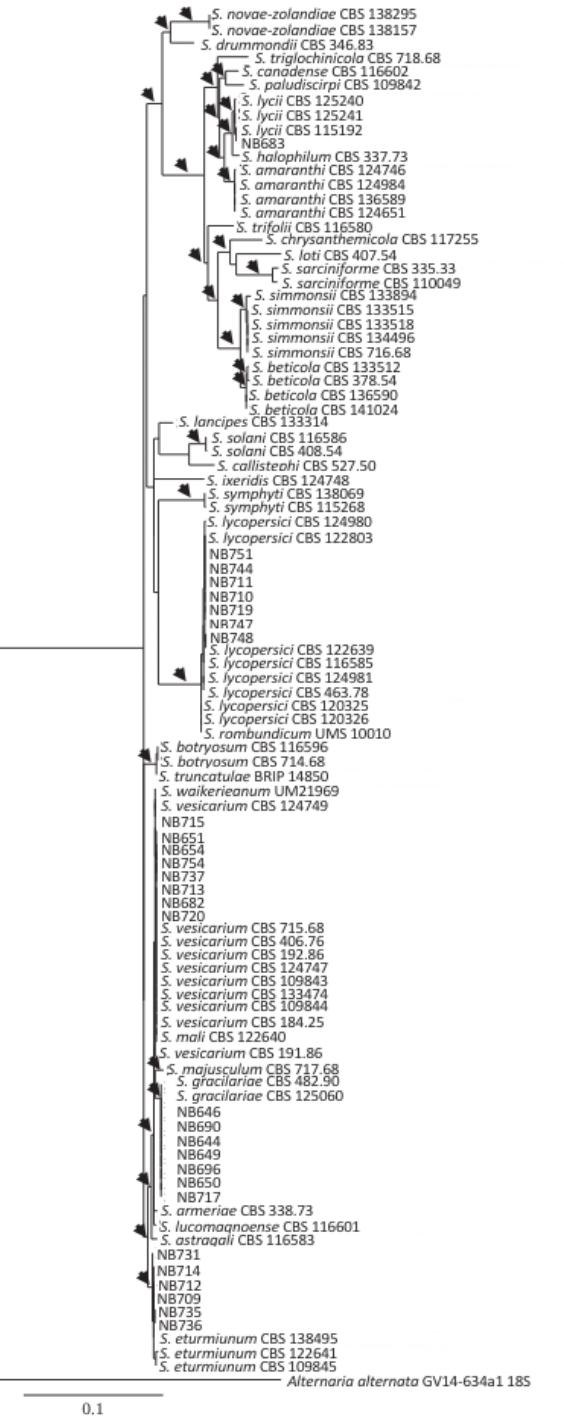
Figure 3. Phylogenetic tree reconstructed using the maximum like- lihood method, from the alignment of ITS , gpd and cmdA sequenc- es of Stempylium isolates . The tree was rooted with Alternaria alter- nata isolate GV14-634a1. Bootstrap support values greater than 0.7 are indicated by arrows near nodes. The scale bar indicates the expected number of substitutions per